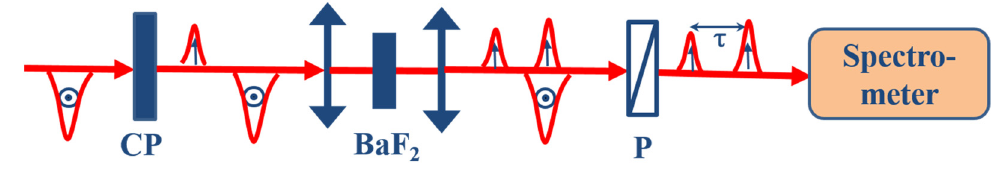
Figure 5. Principle of XPW-SRSI. CP is a calcite plate used to generate a delayed test pulse with polarization perpendicular to that of the incident pulse, and P is a polarizer.